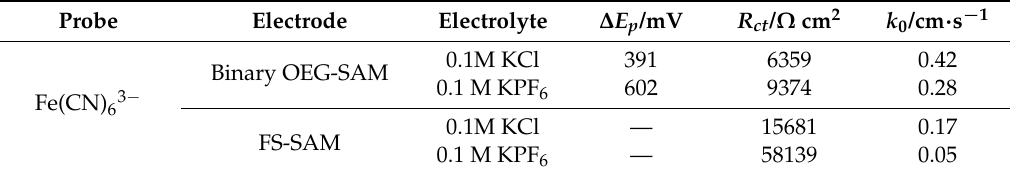
Figure 4. CV ( A ) and electrochemical impedance spectroscopy (EIS) ( B ) of 10 mM Fe (CN) 63 − in different electrolyte solutions on the binary OEG-SAM and the FS-SAM-modified gold electrodes: the binary OEG-SAM-modified gold electrodes in 0.1 M KCl (curve a ) and 0.1 M KPF 6 (curve b ) and the FS-SAM-modified gold electrodes in 0.1 M KCl (curve c ) and 0.1 M KPF 6 (curve d ). CV scan rate, 100 mV/s; pH: 7.0. Table 2. CV and EIS results for 10 mM Fe (CN) 63 − on different electrodes.